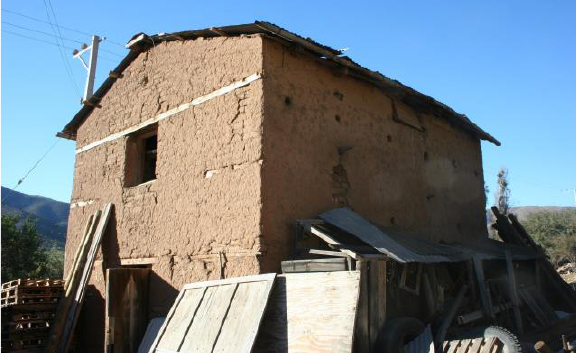
Figure 3. Adobe furnace in Chuchiñí, in which both continuous and corner horizontal wooden reinforcements can be identified.